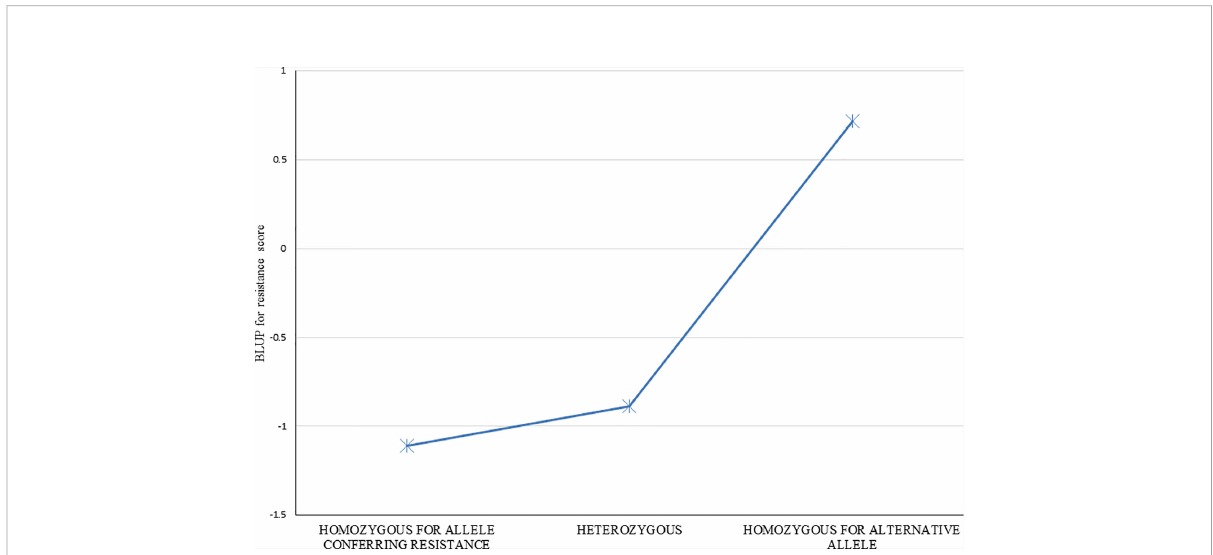
FIGURE 5 Resistance to red rot of groups of clones with the three different observed SNP marker genotypes (ie. Each of two homozygotes, and the heterozygote) for the markers found associated with red rot resistance at P<10 -7 . Average resistance score BLUPs for genotypes within each of the three groups were determined for each of the 35 markers individually, and the average of all 35 markers is